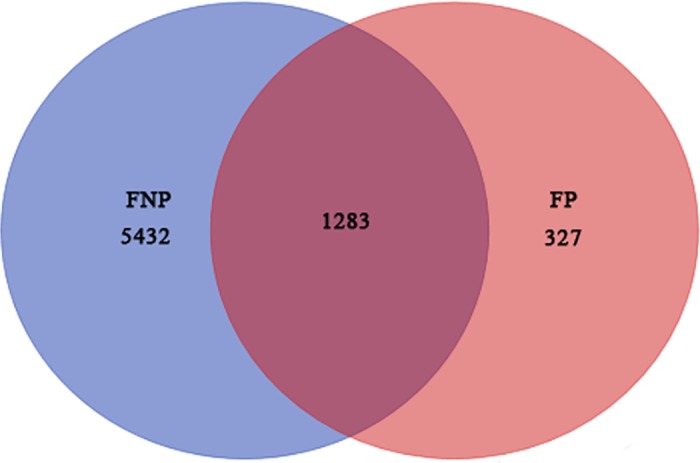
Venn diagram of DEGs identified in FNP and FP plants.The differentially expressed genes shared between FNP and FP plants. Red numbers indicate the gene identified in FP from 6 to 24 DAS; numbers of differentially expressed genes in FNP plants from 6 to 24 DAS are shown in blue.